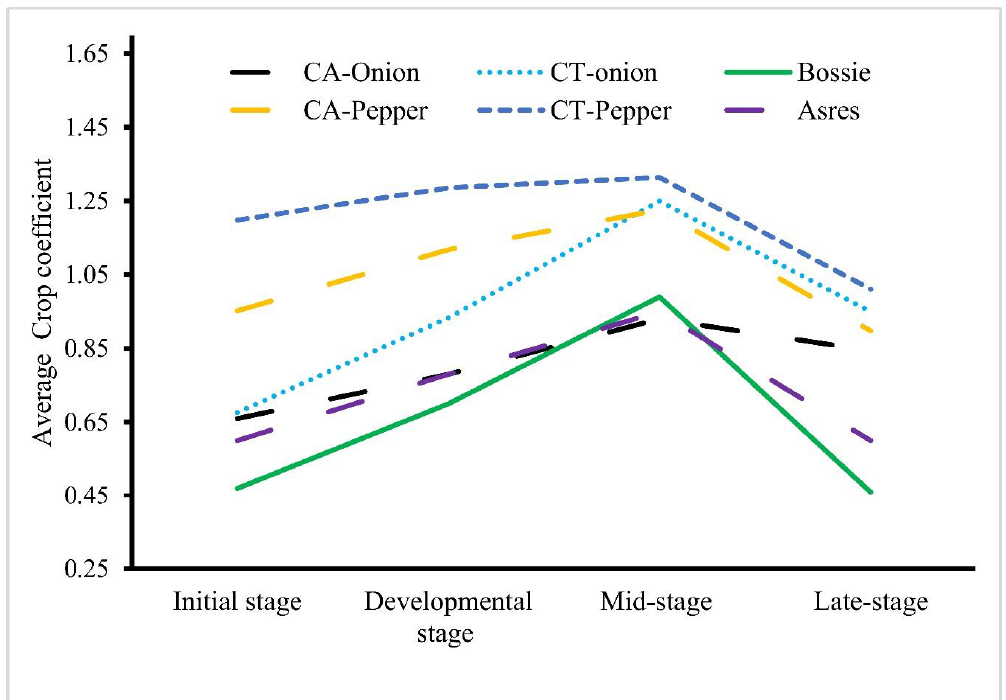
Figure 9. Crop coefficient values of onion compared with Bossie et al. [58] and pepper compared Figure 9. Crop coe ffi cient values of onion compared with Bossie et al. [58] and pepper compared with with Asres [66] for CA management and CT practice. Asres [66] for CA management and CT